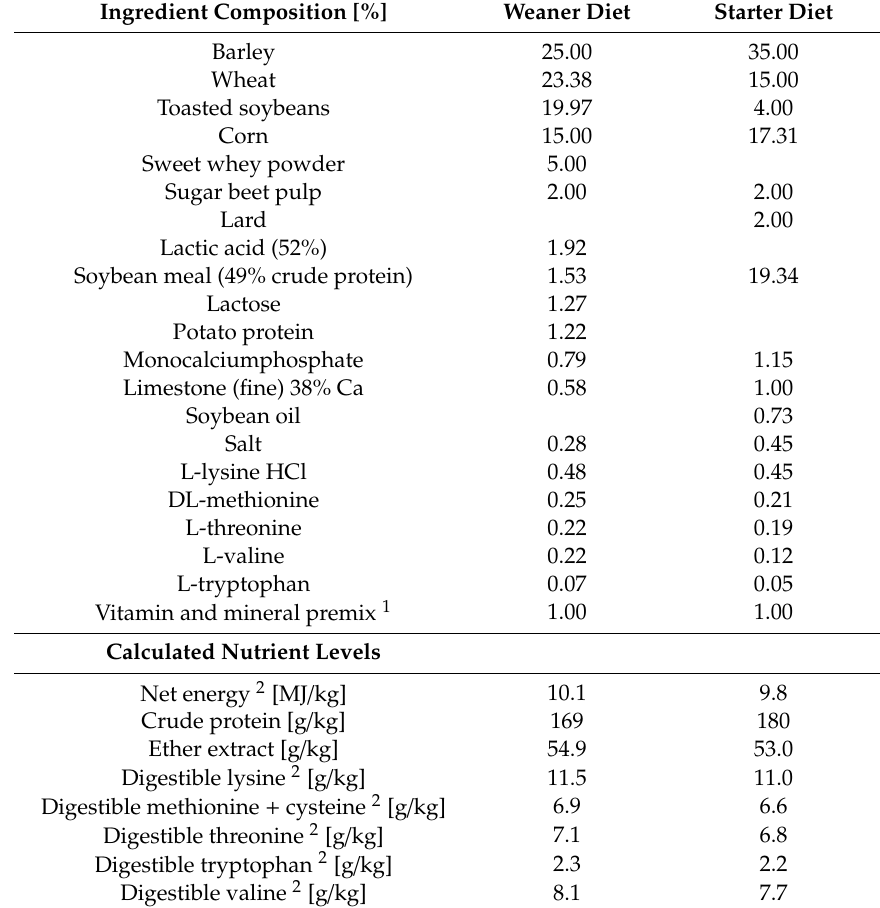
Table 1. Ingredient and calculated nutrient composition of the weaner and starter diet, fed to piglets from d0–14 and d14–42 post-weaning,